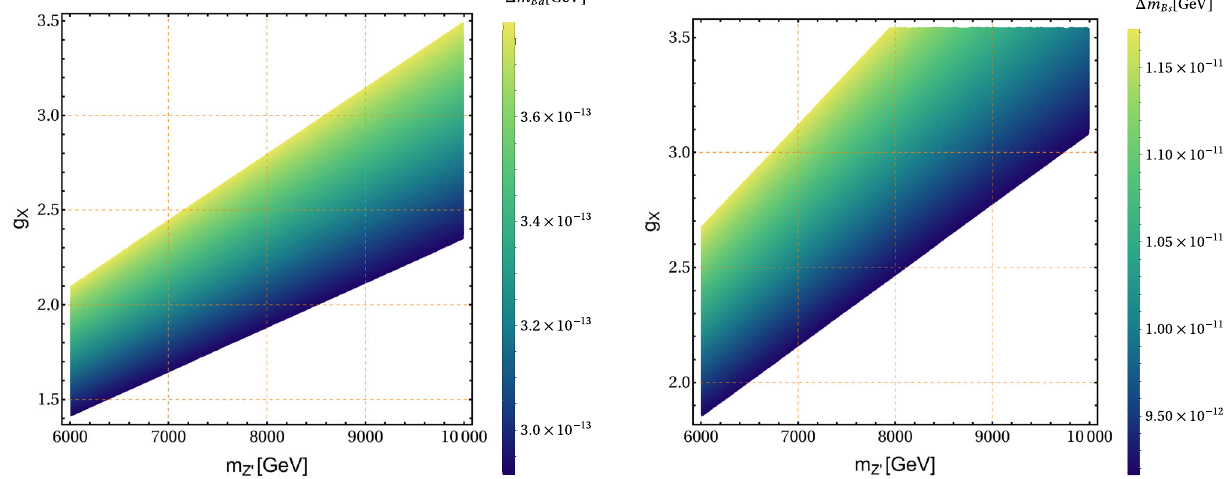
− ¯ B 0 (left-plot) and B 0 s − ¯ B 0 s (right-plot) mixings. d d